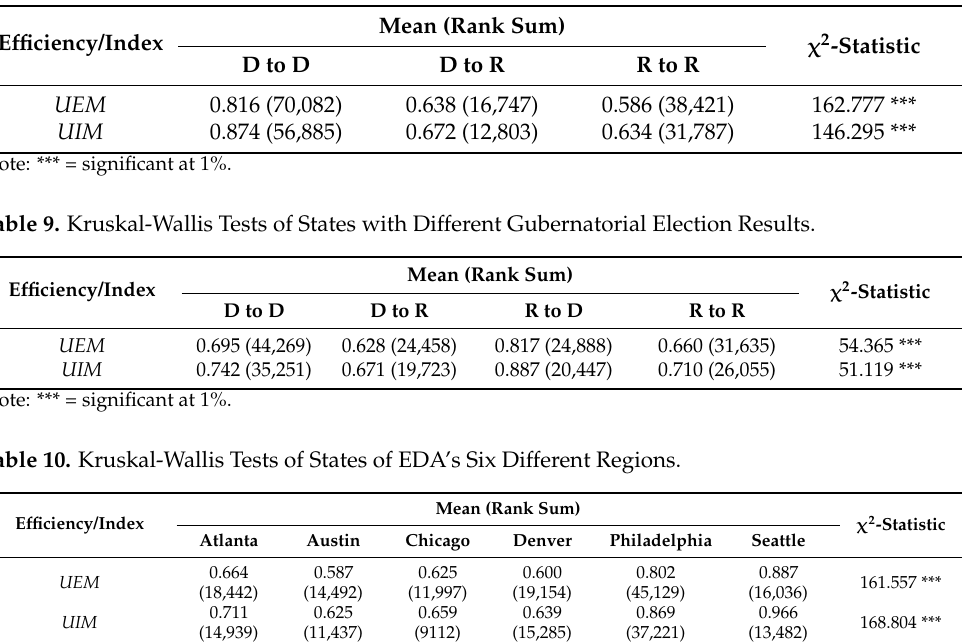
Table 8. Kruskal-Wallis Tests of States with Different Presidential Election Results.